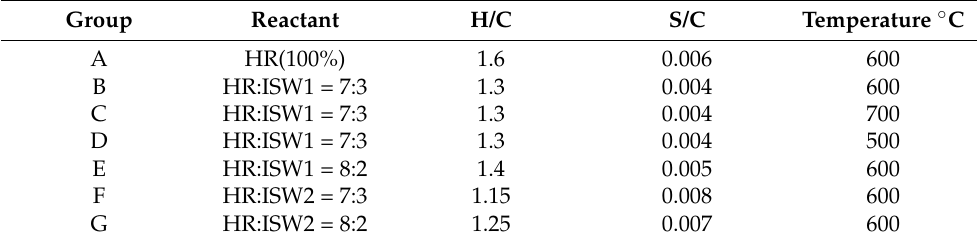
Table 3. Experimental conditions.